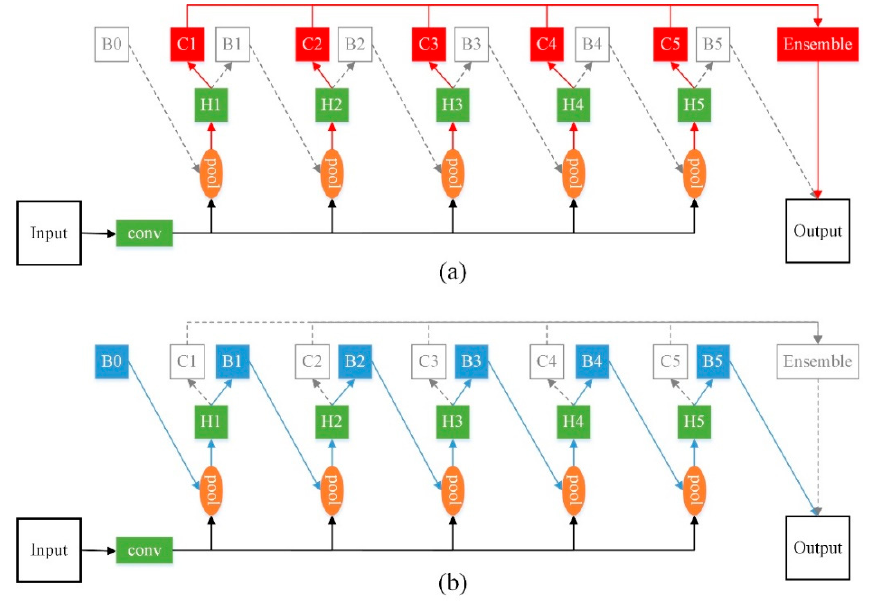
Figure 3. Structure of the proposed Cascade R-CNN++ with five stages. ( a ) Workflow of cascaded classification using a new ensemble strategy (red lines). ( b ) Workflow of cascaded bounding box regression (blue lines) embedded with a modified regression loss function. “Conv” denotes the backbone convolution layer; “pool” is the RoI pooling layer; “H1”, “H2”, “H3”, “H4”, and “H5” are the network heads; “B0” denotes region proposals; “B1”, “B2”, “B3”, “B4”, and “B5” represent the bounding boxes in each stage; and “C1”, “C2”, “C3”, “C4”, and “C5” denote the classifiers in each